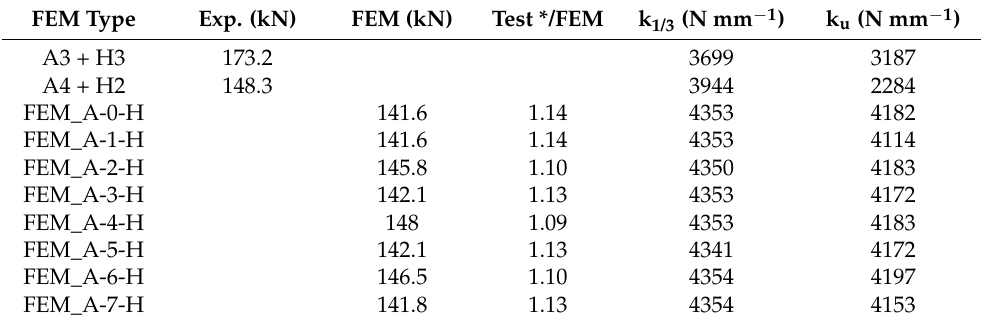
Table 6. Comparison of the test results with FEM predictions with different grain deviation angles for reinforced timber beam with GFRP H-type profiles.